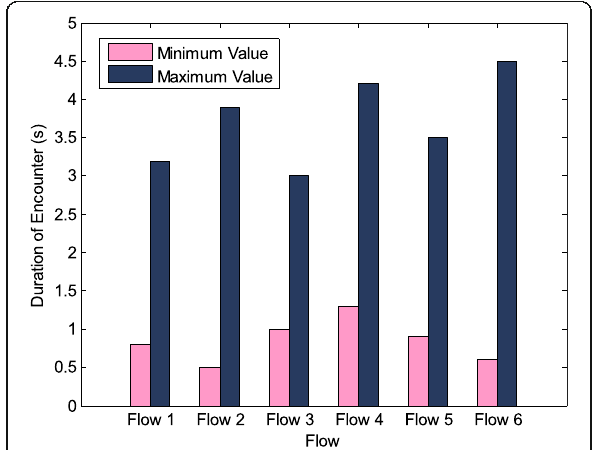
Fig. 6 Comparison between minimum value and maximum value of encounter duration among different per-link flows